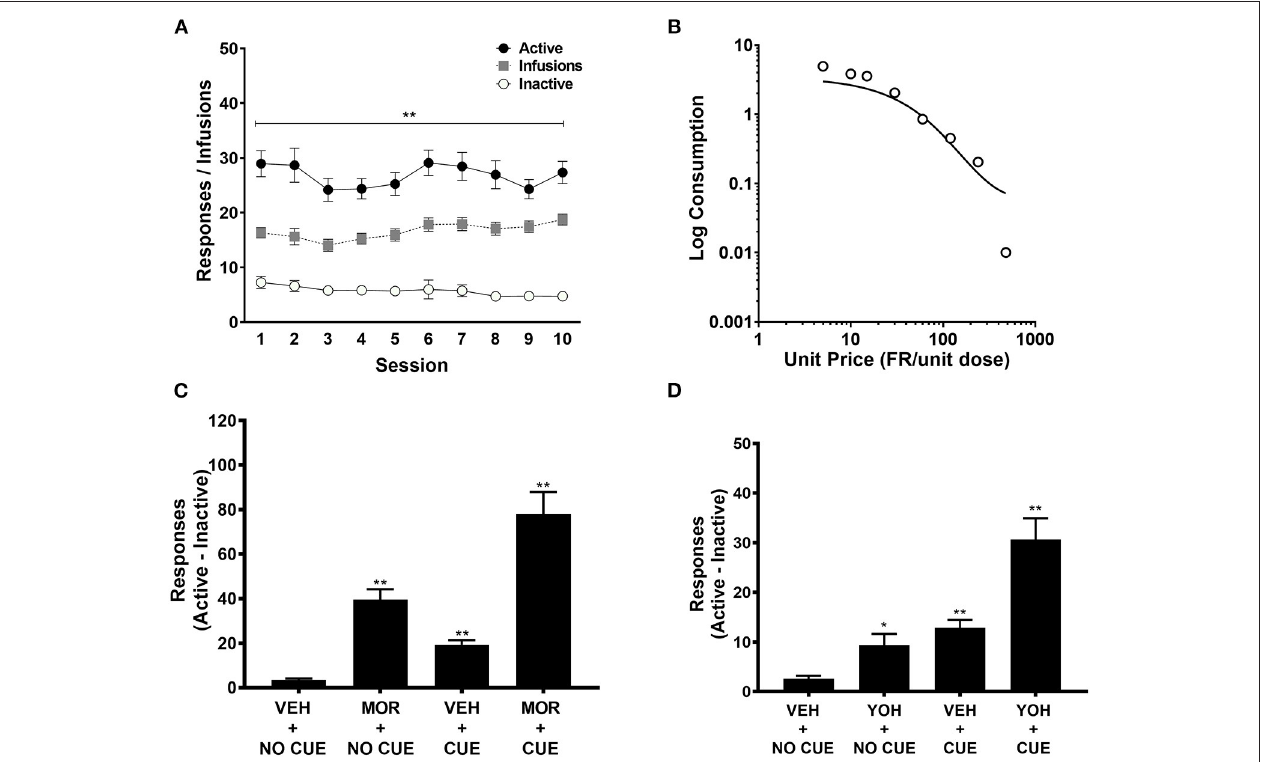
FIGURE 2 | Active and inactive lever pressing during acquisition ( n = 43), (A) ; exponential demand curve for morphine intake during demand testing ( n = 43) (B) ; difference scores between active and inactive lever pressing during morphine-induced ( n = 43) (C) and yohimbine-induced ( n = 43) (D) reinstatement. These data are derived from Swain et al. ( 14), but are here pooled across groups irrespective of treatment prior to MSA. MOR, Morphine; YOH, Yohimbine; VEH, Vehicle. Data points represent mean ± SEM. *Significant difference compared to inactive lever pressing or VEH + NO CUE responding, p < 0.05; ** p < 0.01.